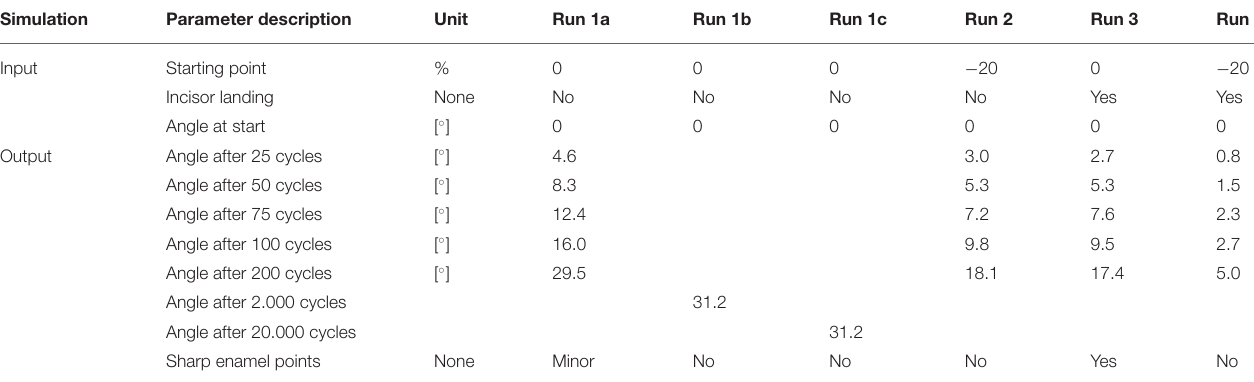
TABLE 1 | Overview of selected simulation input and output parameters of the simulation runs.